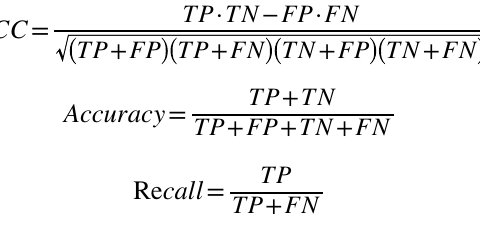
Figure 2. Affinity distribution of 3616 5-HT 3616 5-HT R ligands retrieved from the ChEMBL database version 5. 1A doi: